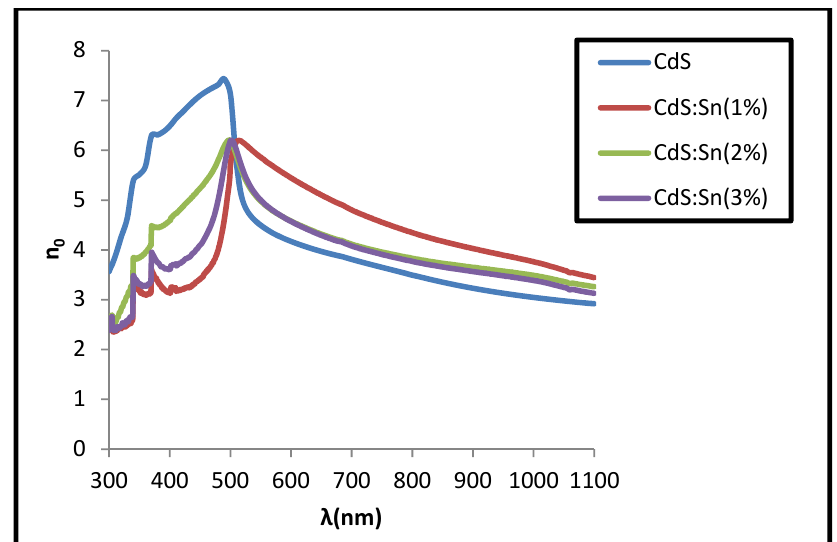
Fig. 6: The variation of the refractive index as a function of the wavelength for CdS and CdS:Sn thin film.